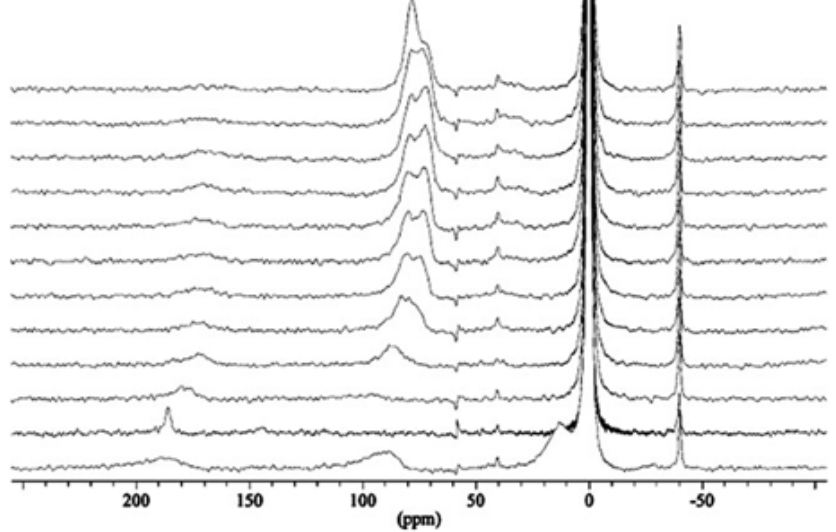
Figure 8. In situ transformation of 2a SLNs ( bottom ) after a pulse of methylene chloride (next to bottom ) as monitored by continuous flow hyperpolarized 129 Xe MAS NMR.